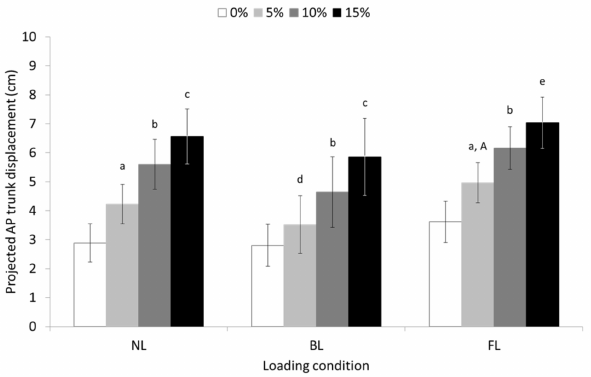
Figure 7. Means and 95% confidence intervals (error bars) for the projected anteroposterior (AP) trunk displacement, during unloaded (UL), back-loaded (BL), and front-loaded (FL) walking at 0 (level),